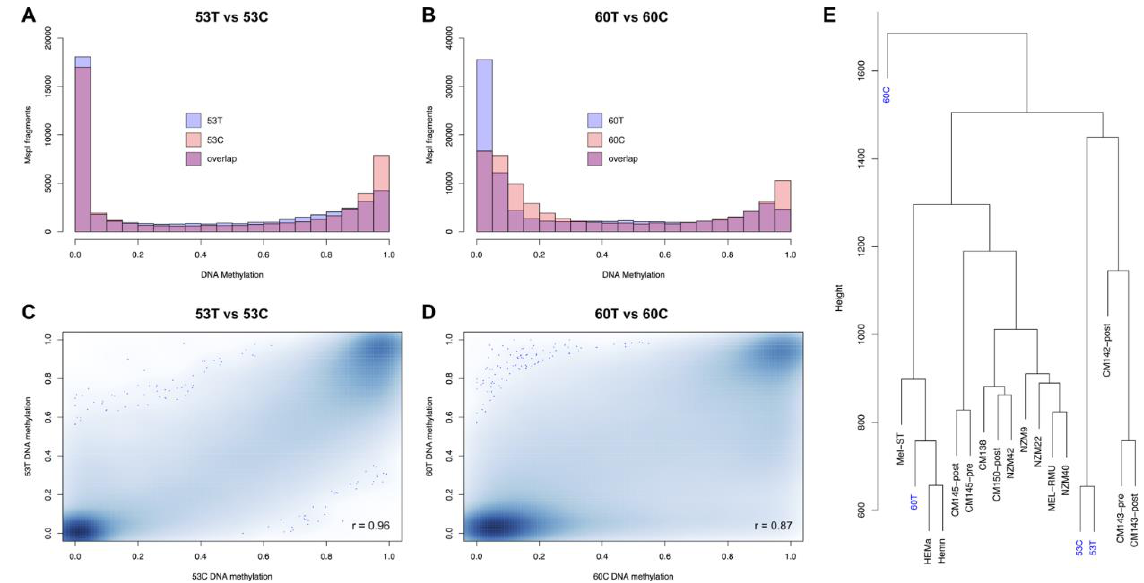
Figure 1. Global methylation patterns in melanoma tissues and derived cell lines. ( A , B ) Histograms showing the degree of methylation in all analysed RRBS fragments of 53T compared to 53C ( A ) and 60T compared to 60C ( B ). The x axis represents methylation level on a 0–1 scale and the y axis is the number of RRBS fragments in each bin. ( C , D ) Smoothed colour density scatterplots show the correlation of methylation in tissues ( y axis) with respect to their derived cell lines ( x axis). ( E ) Hierarchical clustering of RRBS fragments together with 3 normal melanocyte cell lines (Mel-ST, HEMa-LP and HEMn-LP) and 12 metastatic melanoma cell lines (CM145-post, CM145-pre, CM150-post, CM142-post, CM138, CM143-pre, CM143-post, MEL-RMU, NZM9, NZM22, NZM40 and NZM42).